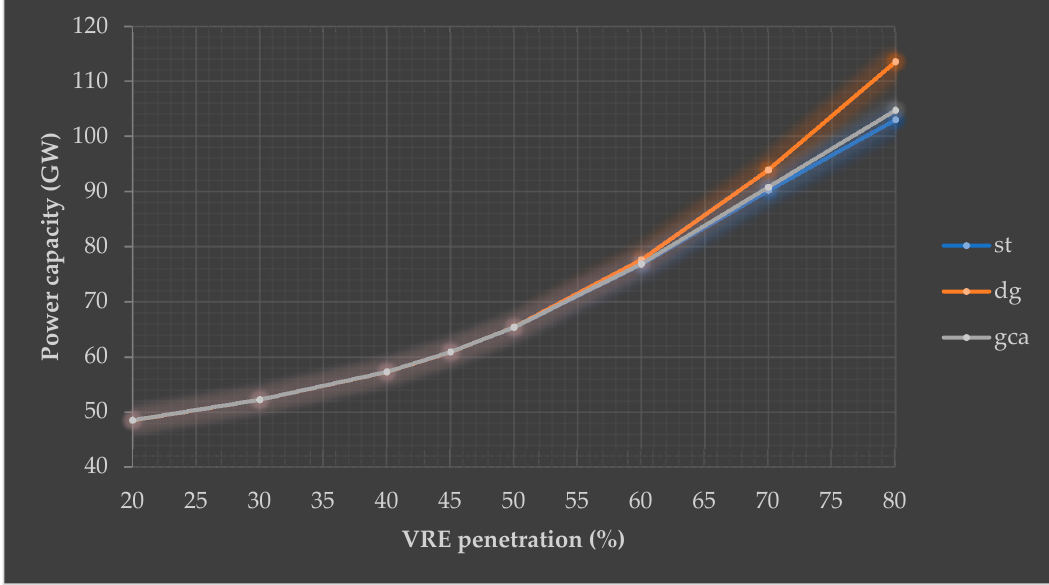
Figure 8. European power capacity requirement analysis results based on different VRE penetration levels of the 2040 ENTSO-E scenarios.